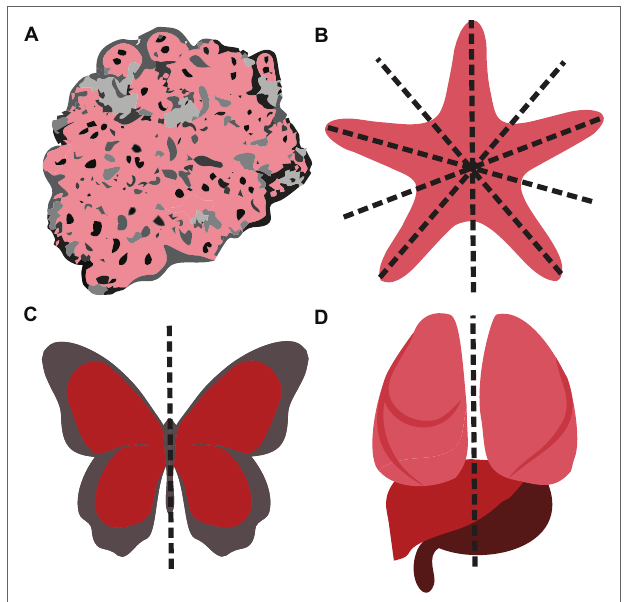
FIGURE 1 | The major types of body plans. (A) Asymmetry. (B) Radial symmetry. (C) Bilateral symmetry. (D) Due to the asymmetrical position of internal organs, humans and other vertebrates have been described as pseudo-bilateral (Levin,